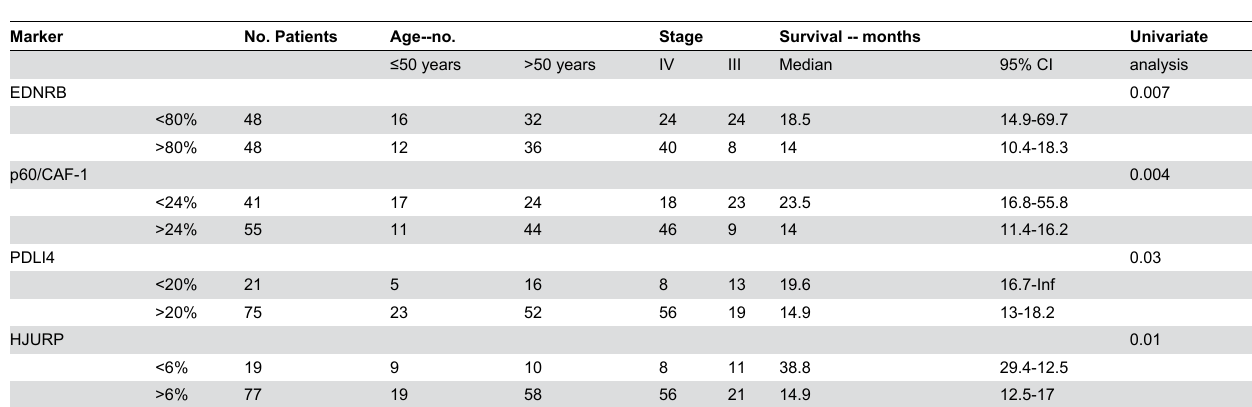
Table 4. Immunohistochemical results for EDNRB, HJURP, p60/CAF-1 and PDLI4, and univariate survival analysis.